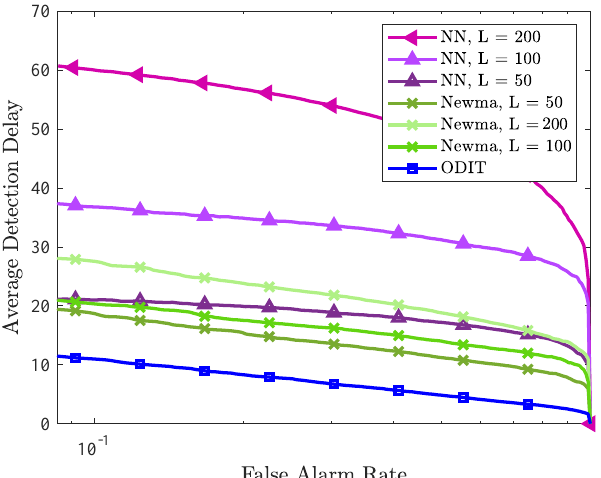
Figure 9. Performance comparison of ODIT, NN, NEWMA detectors in the seizure detection experiment. The performances are evaluated in terms of average detection delay vs. false alarm rate (in log-scale) and are averaged over all patients and dog subjects.